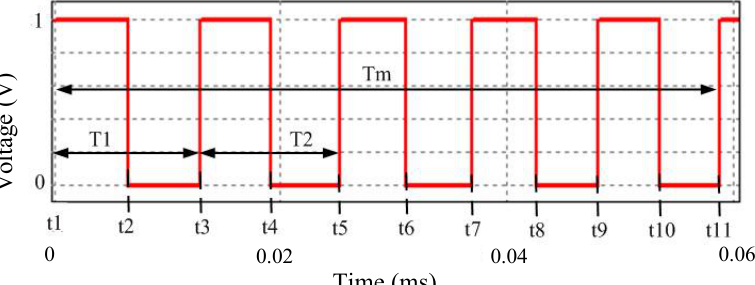
Figure 2. Simulated square control signal waveform with periodic SFM. Parameters: central switch- ing frequency f 0 = 85 kHz; Δ f peak = 10 kHz; f m = 17 kHz. Modulation waveform is ramp.